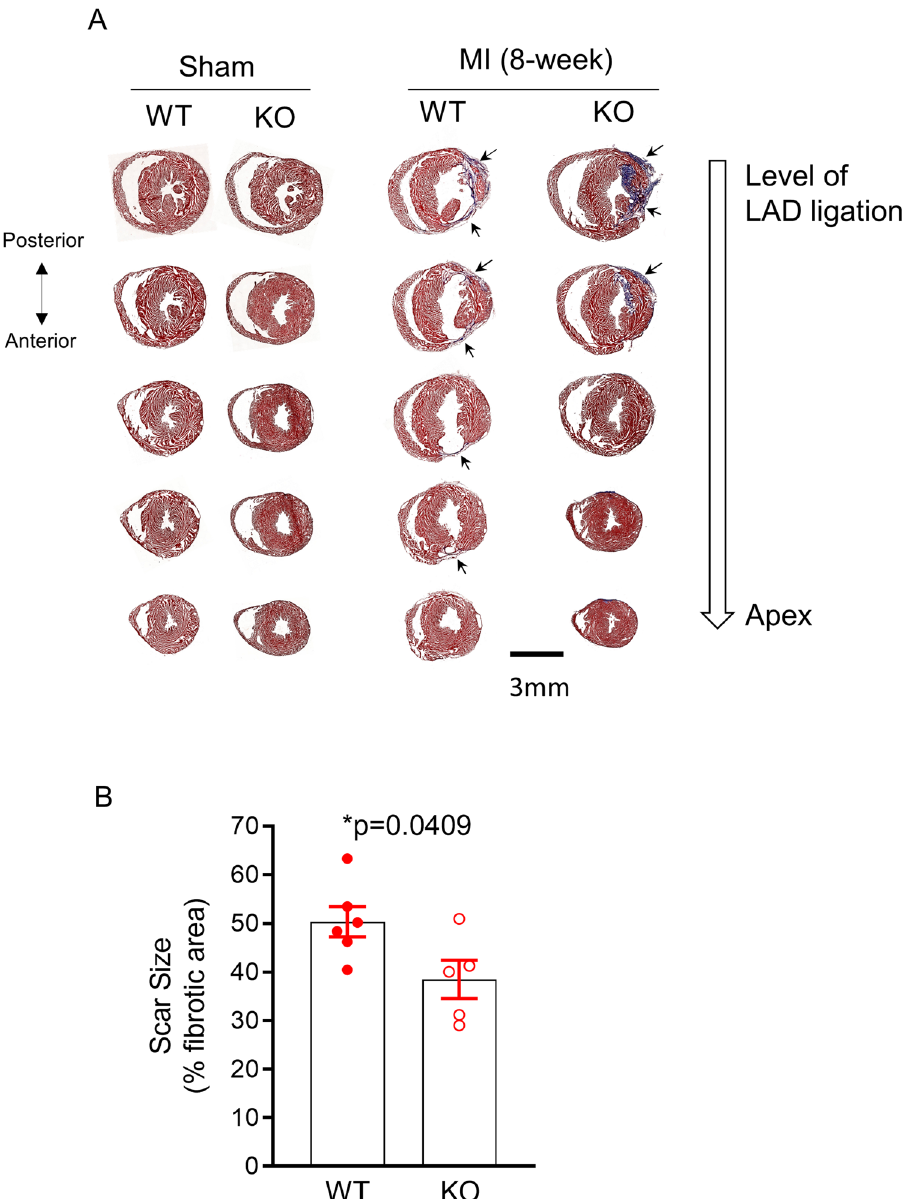
Figure 4. β-catenin knockout reduces scar sizes after myocardial infarction. ( A) Representative images of Masson’s trichrome staining of mouse heart tissue sections at 5 different levels from LAD ligation site (top) to the apex (bottom) at 8 weeks after MI (right), as well as in sham-operated hearts (left). The scar size for each the 5 different levels was calculated as the percentage of fibrotic area (as indicated by the arrows) to the total area of the left ventricle section. The heart’s total scar size was then calculated as the mean of the scar sizes at the 5 levels and reported in panel B. ( B) Summary of scar size showing reduced scar size in KO hearts (n = 5) compared to WT hearts (n = 6). Statistical analysis was performed with a two-tailed unpaired